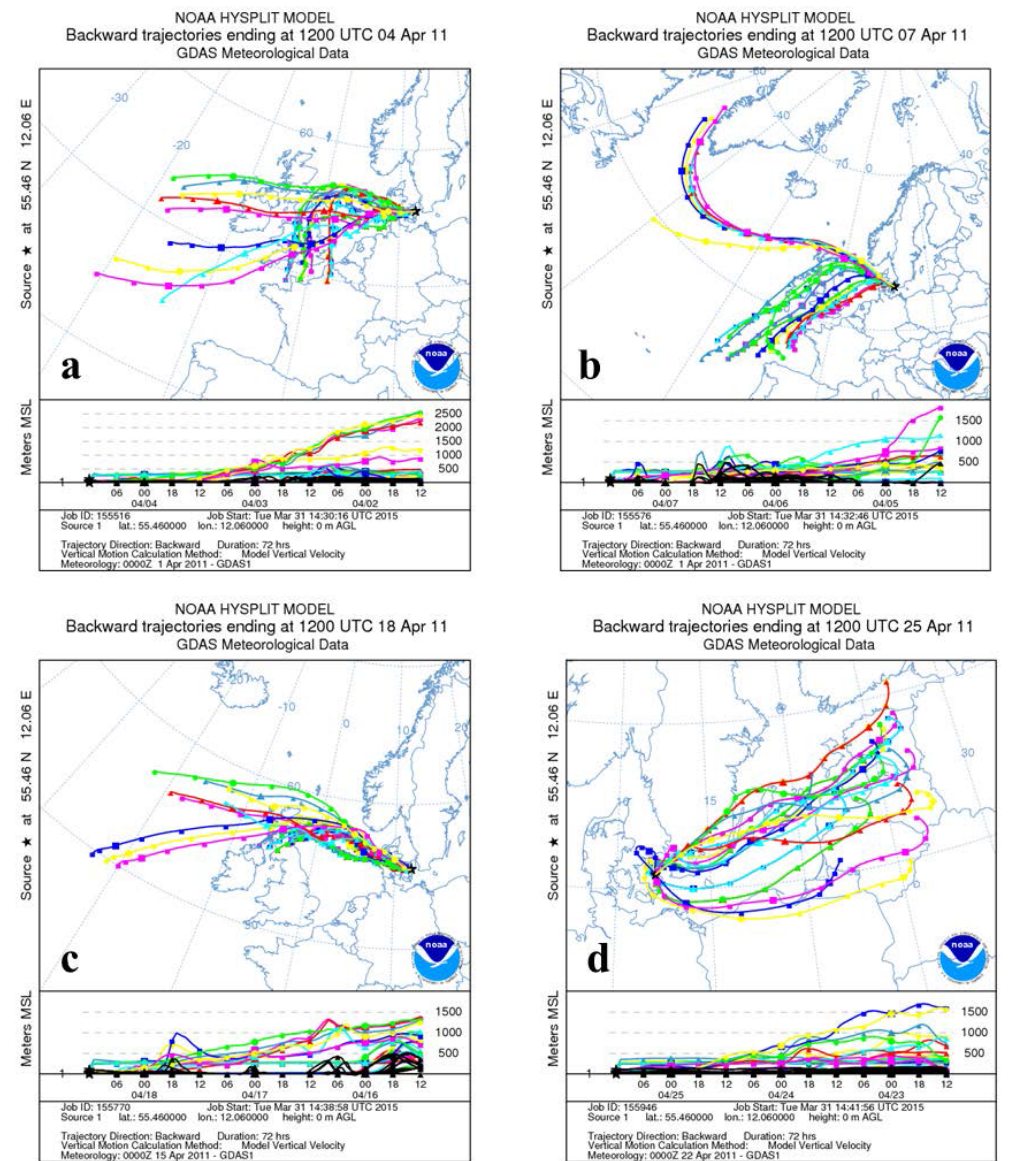
Figure 6. The 72h (3days) air mass back trajectories for starting altitudes of 0m above ground level (a.g.l.) calculated from the FNL database of the National Ocean and Atmospheric Administration (NOAA) and simulated by using the Hybrid Single-Particle Lagrangian Integrated Trajectory (HY-SPLIT) model. 31 March–4 April (a) , 4–7 April 2011 (b) , 14–18April (c) and 21–25 April 2011 (d)